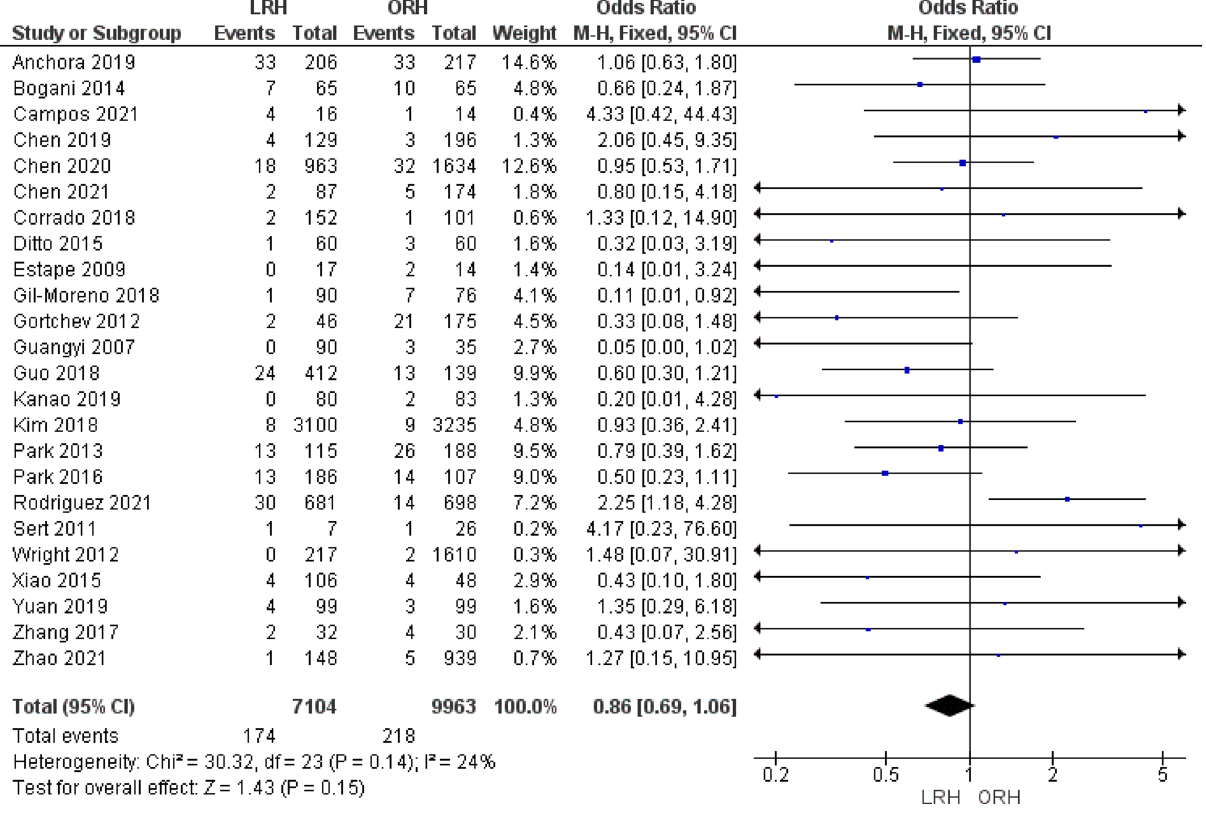
Figure 10. Forest plot of the postoperative or intraoperative mortality